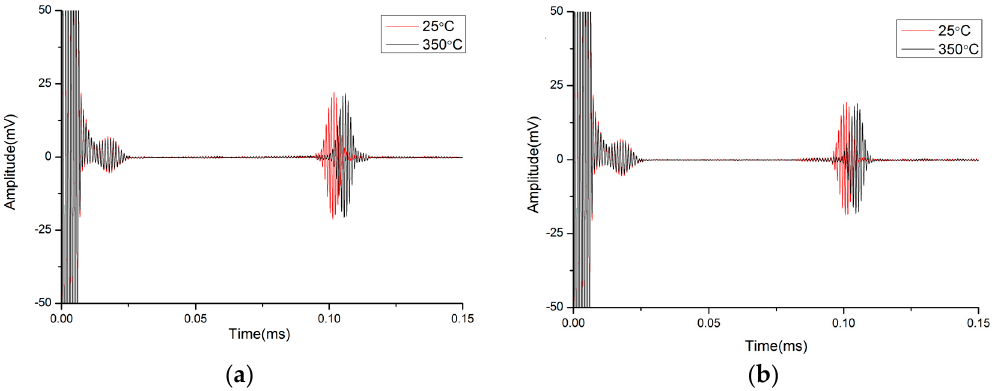
Figure 16. The received signals of waveguide bars: ( a ) Waveforms of No. 1; ( b ) Waveforms of No. 4.